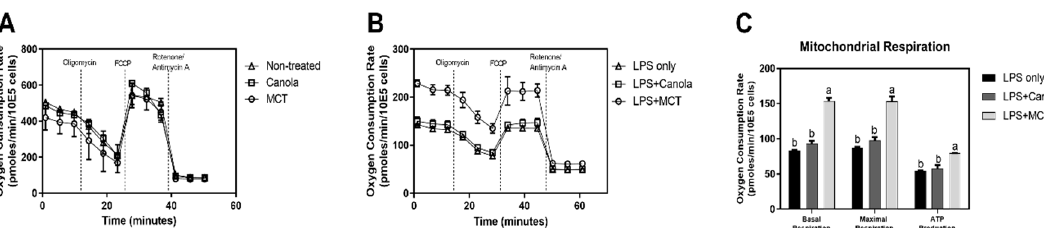
Figure 1. Medium chain triglyceride (MCT) exacerbates mitochondrial oxygen consumption in RAW 264.7 cells. The oxygen consumption rate (OCR) was measured as a marker of oxidative phosphorylation (OXPHOS) using a Seahorse Extracellular Flux analyzer. Samples were initially treated with oils under non-stimulated ( A ) and lipopolysaccharide (LPS)-stimulated conditions ( B ). During extracellular flux analysis, cells were sequentially treated with oligomycin, carbonyl cyanide-4-(trifluoromethoxy)phenylhydrazone (FCCP), and rotenone with antimycin A to assess OXPHOS phenotype based on OCR levels. Based on OCR data (B), the basal respiration, maximal respiration, and ATP production were calculated and are indicated as OCR in pmoles / min ( C ). Data are presented as mean ± SEM ( n = 4), and significant differences are indicated with different letters ( p < 0.05) within each basal respiration, maximal respiration, and ATP production column.